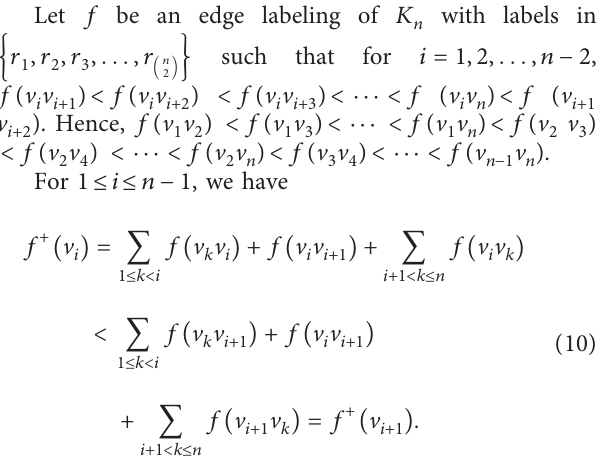
r + r + · · · + r n if n + 1 n + 2